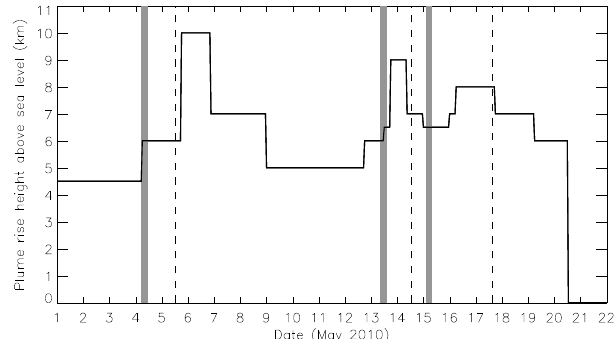
Fig. 8. Time series of the height of the eruption plume above sea level. The dashed lines represent the times at which the FAAM aircraft performed profiles through the ash cloud. The grey shading represents the approximate times that the observed ash particles were emitted fromthevolcano.